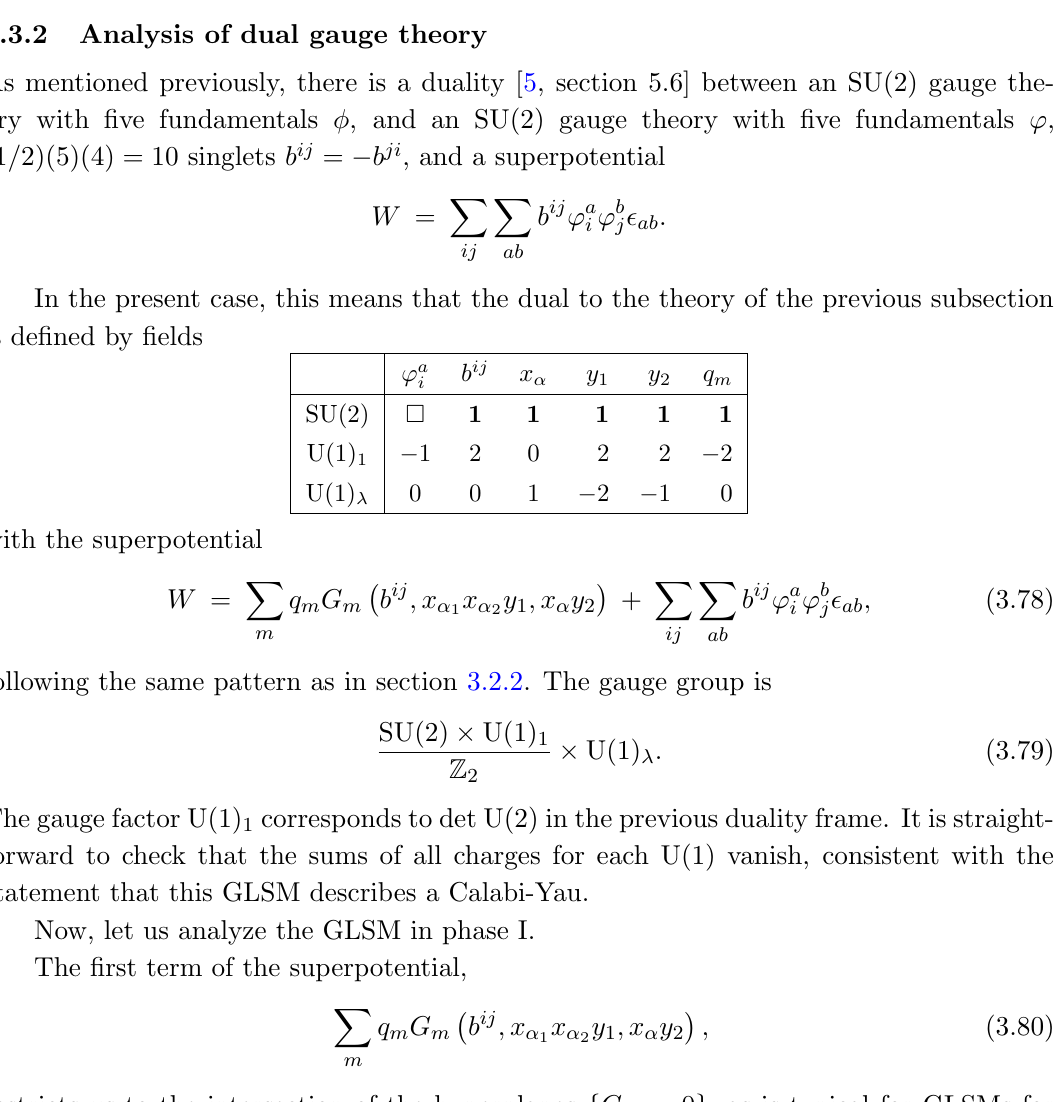
Figure 6 . Components of the